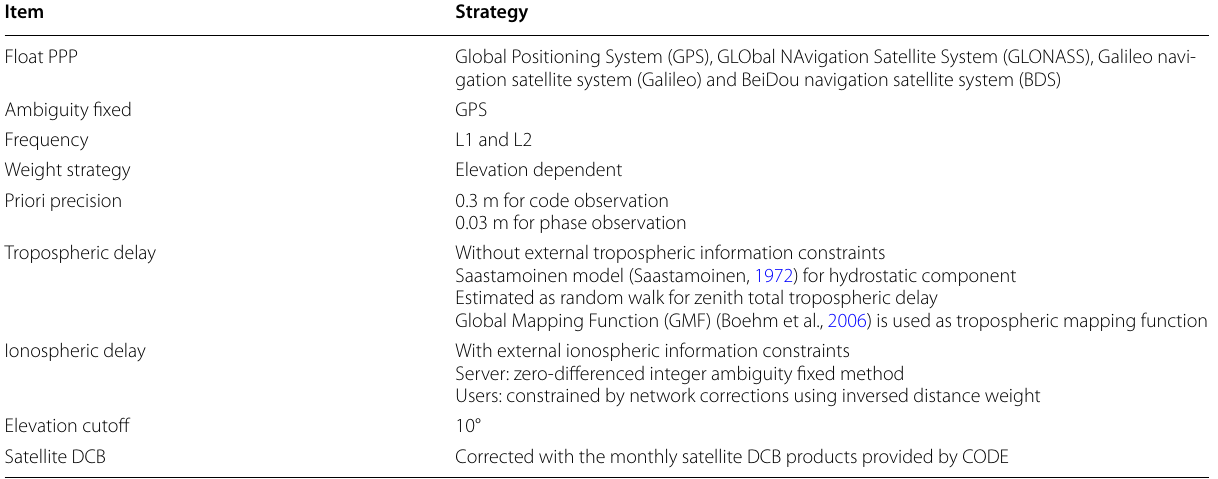
Table 5 The detailed processing setups for PPP–RTK